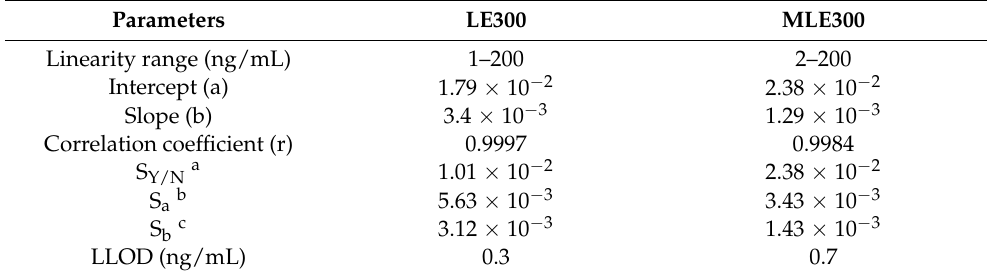
Table 2. Validation parameters for the established LC-MS/MS method of LE300 and MLE300.